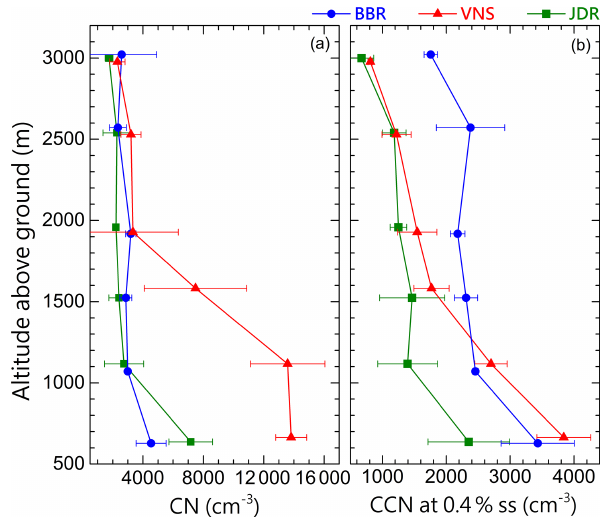
Figure 3. Vertical distribution of regionally averaged (a) aerosol number concentration (CN) and (b) CCN number concentration across the IGP. The circle, triangle and square represent the BBR, VNS, and JDR IGP regions, respectively. Error bars represent the standard deviation around the mean